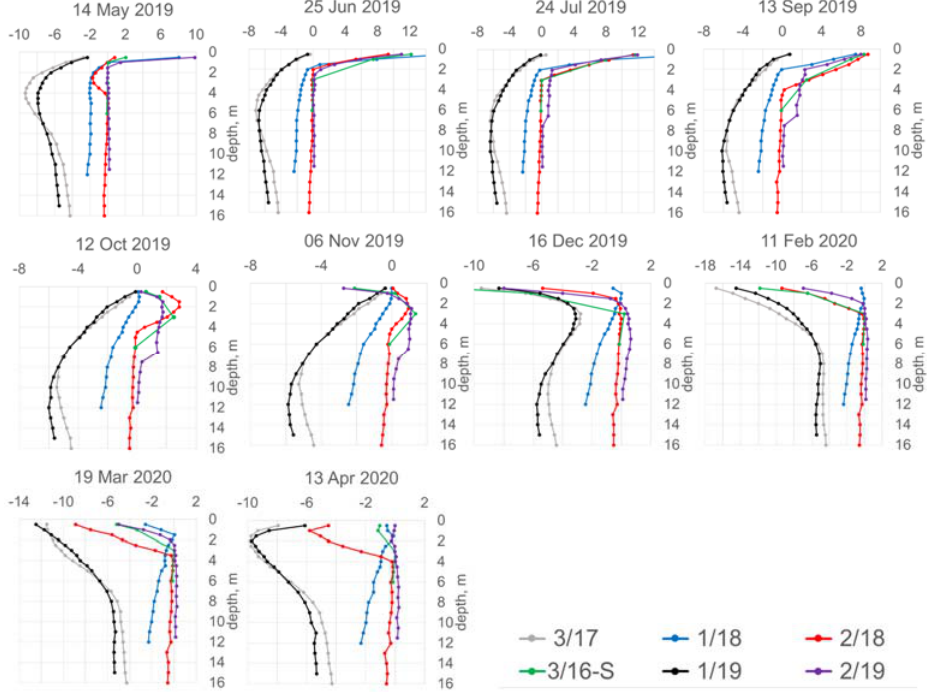
Figure 4. Ground temperature curves at six boreholes for selected dates during the period